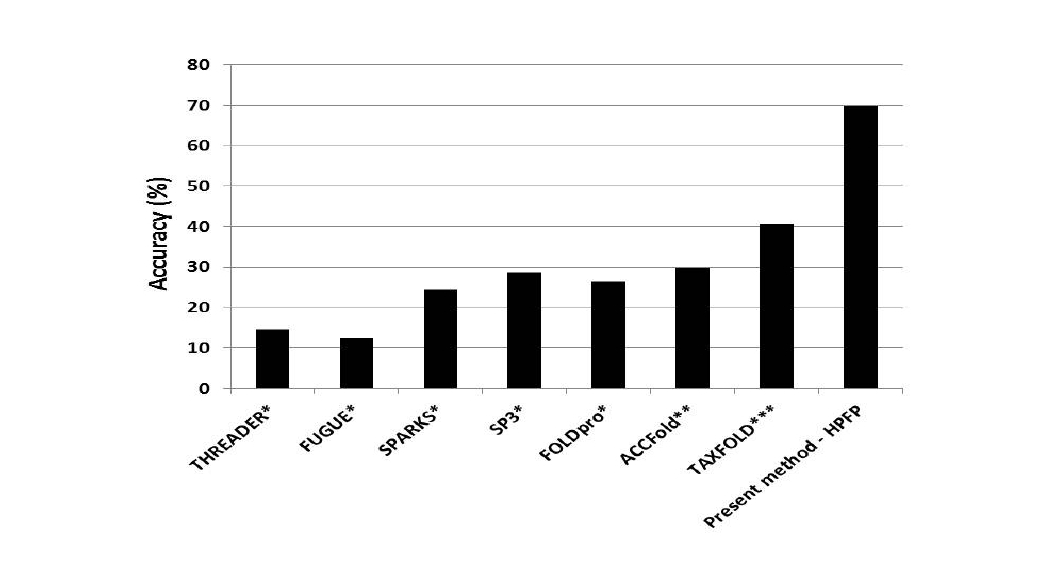
Figure 2: The fold prediction accuracies obtained for different fold prediction methods on Lindahl and Elofsson’s dataset. [ 1 Only top 1 accuracies reported for all the methods. * The results were cited from Ref 25. ** The result was cited from Ref 2. *** The result was cited from Ref